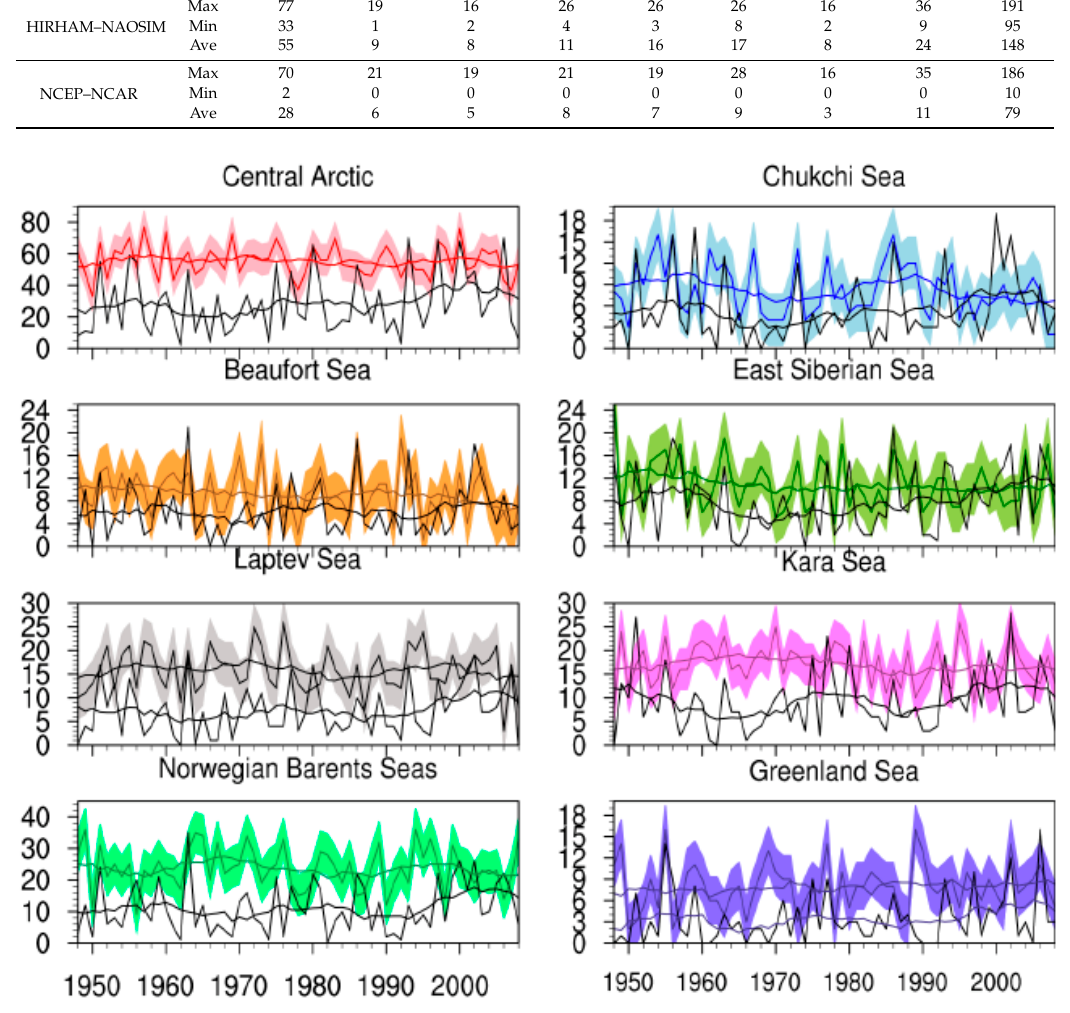
Figure 2. The storm counts derived from the HIRHAM–NAOSIM simulations and the NCEP–NCAR reanalysis dataset for each subregion for summer season (1 July–15 September) during the period of 1948–2008. The solid lines showing high-frequency variability in different colors represent the model ensemble member mean; and the shading in the color corresponding to the solid lines indicates the across-ensemble-member standard deviation. The solid black lines showing high-frequency variability demonstrate the storm counts from the NCEP–NCAR reanalysis dataset. The solid lines in color and black with low-frequency variability represent 11-year running means. Unit: Count per subregion.